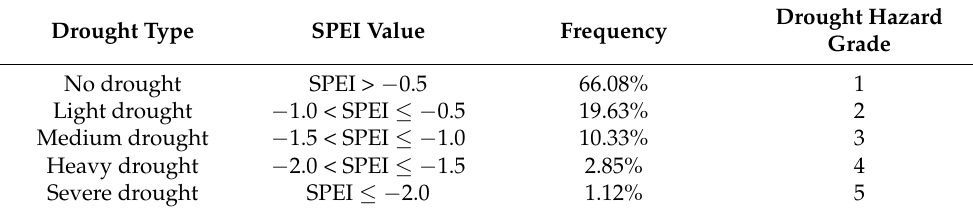
Table 3. Drought frequency at monthly scale (SPEI-1) in the study area.